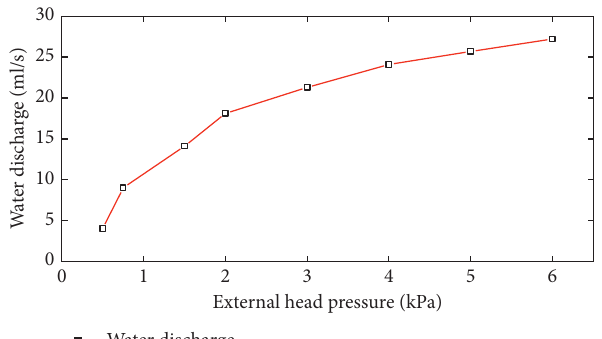
Figure 17: Relationship between the head pressure and the free drainage of the tunnel.